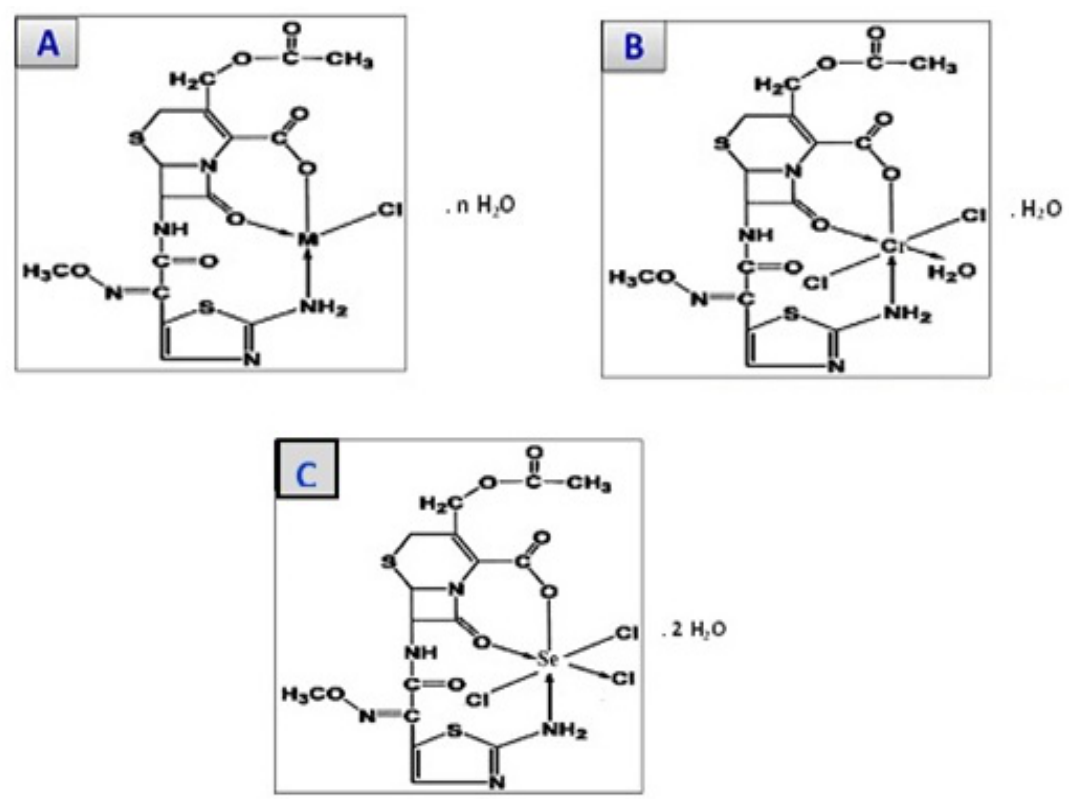
Figure 8. The structures of: ( A ) cefotax/M, where M = Ca (II), Cu(II), and Zn (II), and n = 1, 3, and 2, respectively; ( B ) cefotax/Cr; and ( C ) cefotax/Se.